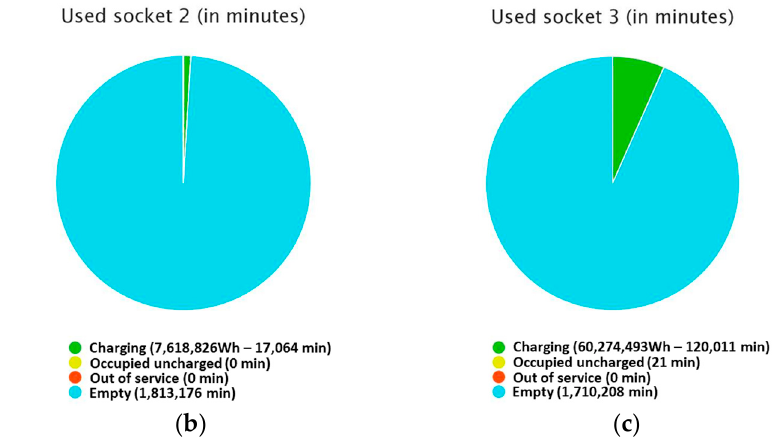
Figure 11. Usage of the charging station in Unirii Square for each socket: ( a ) charging using CHAdeMO standard; ( b ) charging using Type 2 standard; ( c ) charging using CCS standard.